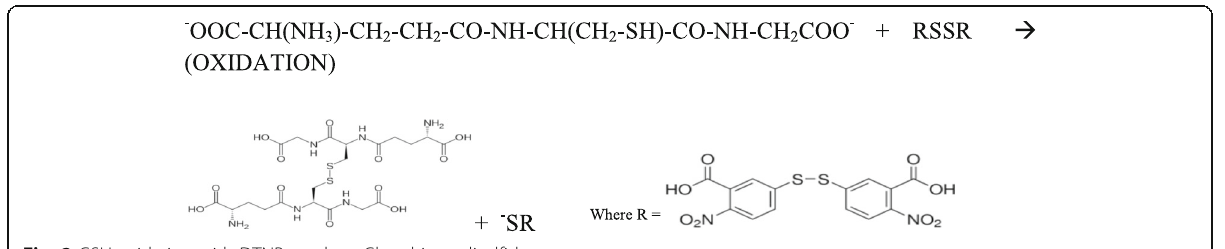
Fig. 2 GSH oxidation with DTNB produce Glutathione disulfide